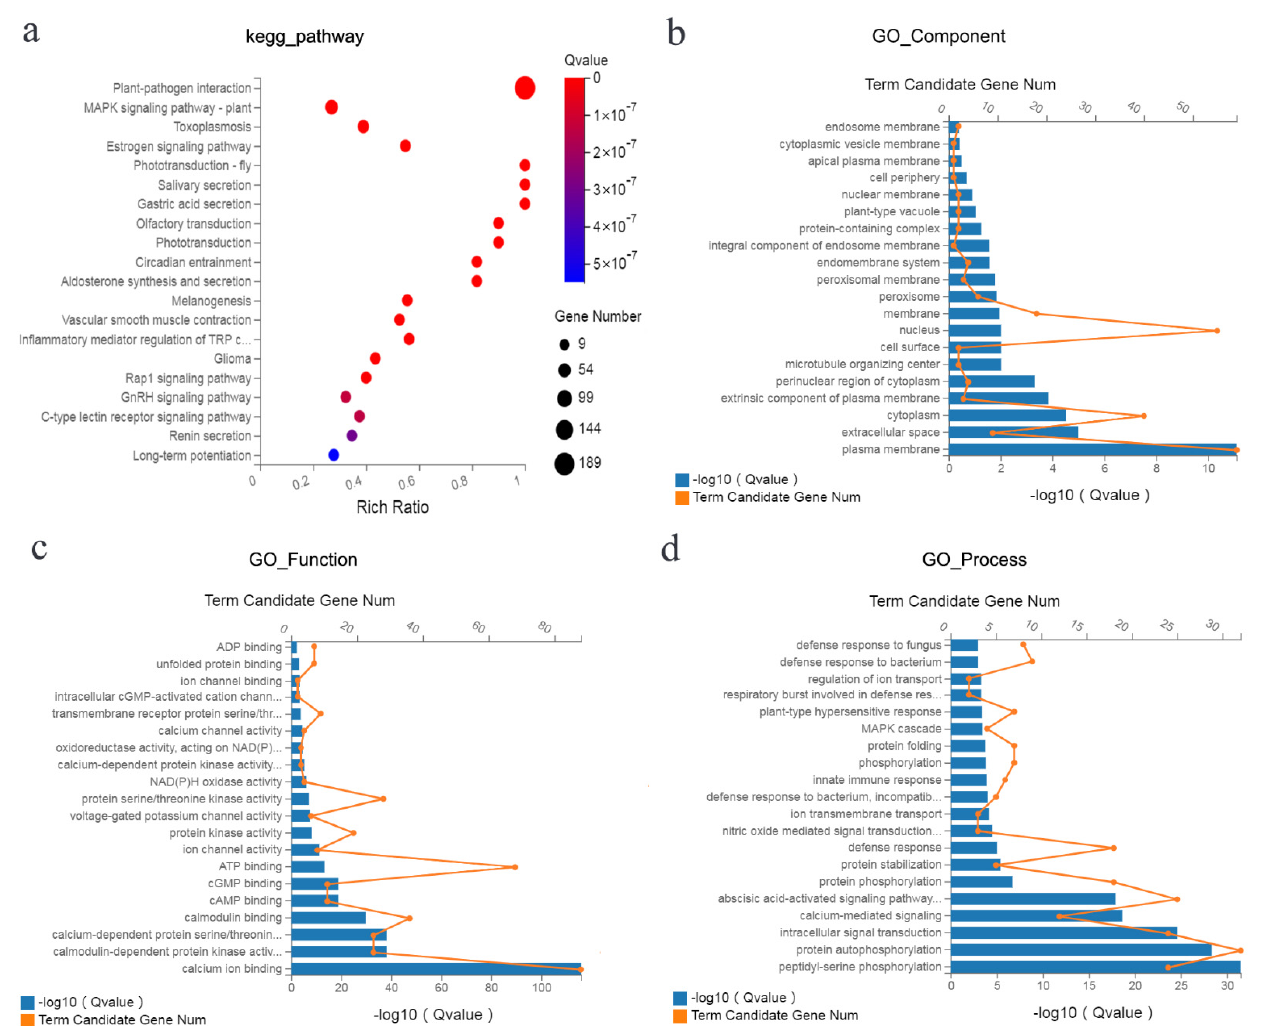
Figure 4. ( a ) KEGG enrichment of 189 DEGs in the ‘plant–pathogen interaction’ pathway. ( b – d )